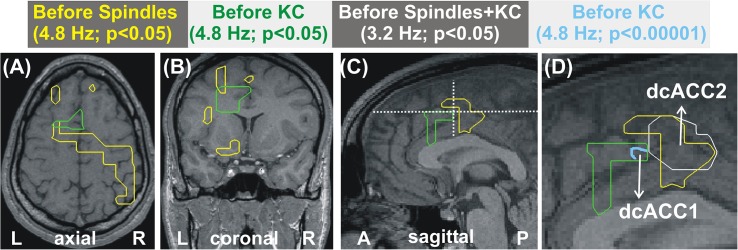
Distinct patterns of increases in spectral power for before spindle and before KC POIs over the NREM2 core periods. The increases are represented as outlines with the color of each outline corresponding to a different contrast as described in the text printed with the same color in each of the panels at the top of the Figure, and described also in this caption below. (A–C) show the areas with modest increase (p < 0.05) at the center frequency of 4.8 Hz for spindles (yellow) and KCs (green). (A,B) are the respective axial and coronal view cut along the lines in the mid-sagittal view in (C). (D) shows a zoomed copy of (C), with the focal area in cyan outline showing prominent (p < 0.00001) increases before KCs. The white outline marks the areas showing the common overlap for modest increases before spindles and before KCs in the slightly lower band (center at 3.2 Hz). The white outline marks much of the area with before spindle increase because the before KC increase at 3.2 Hz covers almost all of the area of the pre-spindle increase and extends well beyond. The centers of the cyan and white outlines are referred to as dcACC1 and dcACC2.